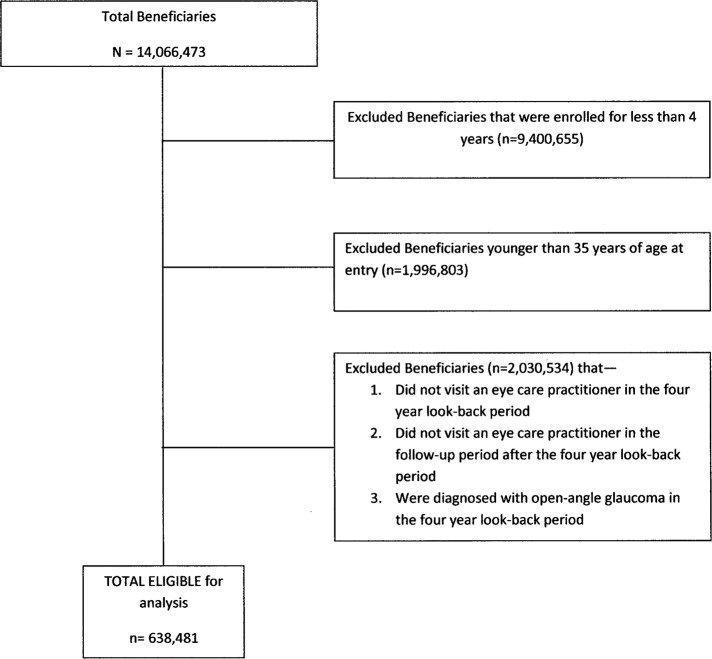
Sample selection process.Sample selection process for identifying elgible enrollees for the analysis.